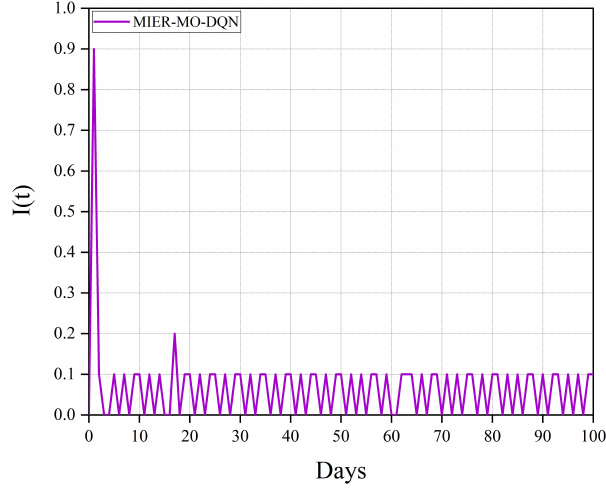
Figure 6. Drug dose of MIER-MO-DQN algorithm in Scenario 1. Table 3. Comparison of experimental indicators in different